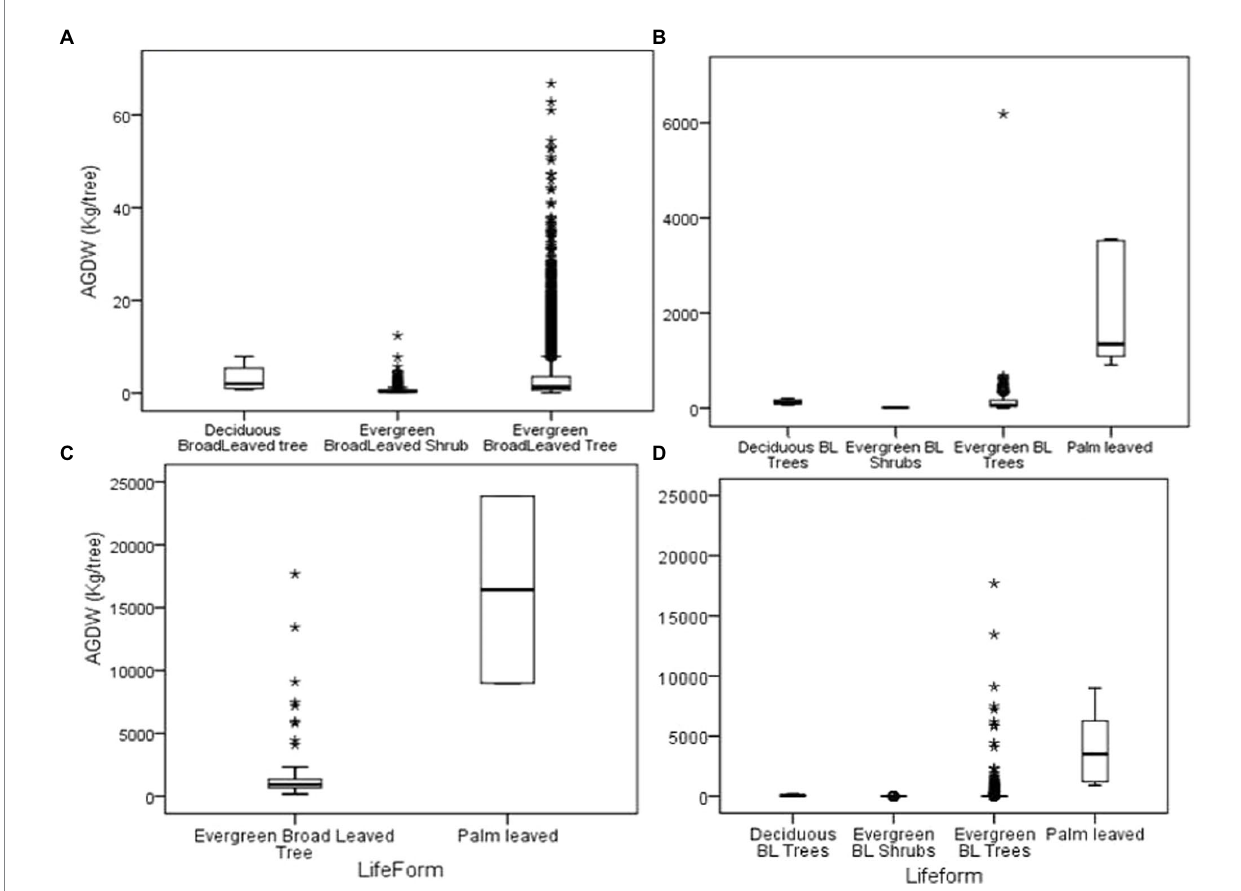
FIGURE 3 Above-ground dry weight (ABDW) for Dinghushan forest: (A) below 10 cm DBH; (B) 10– 30 cm DBH; (C) above 30 cm DBH and (D) the entire forest